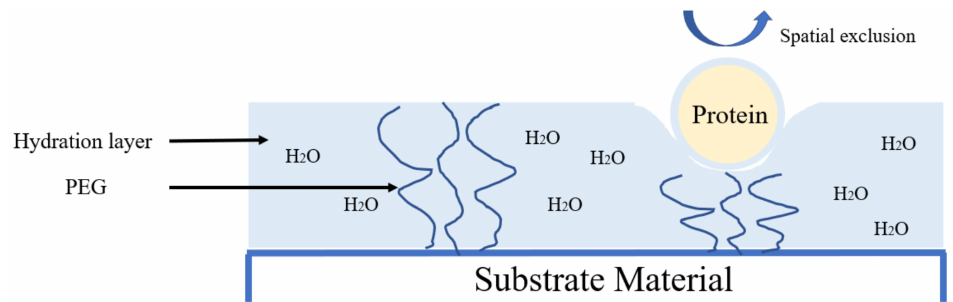
Figure 2. Anti-protein mechanism of polyethylene glycol